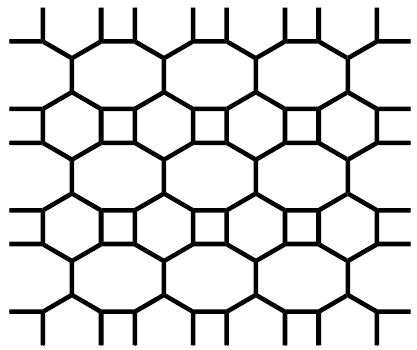
Fig. 5 . The 2-Dimensional Lattice of